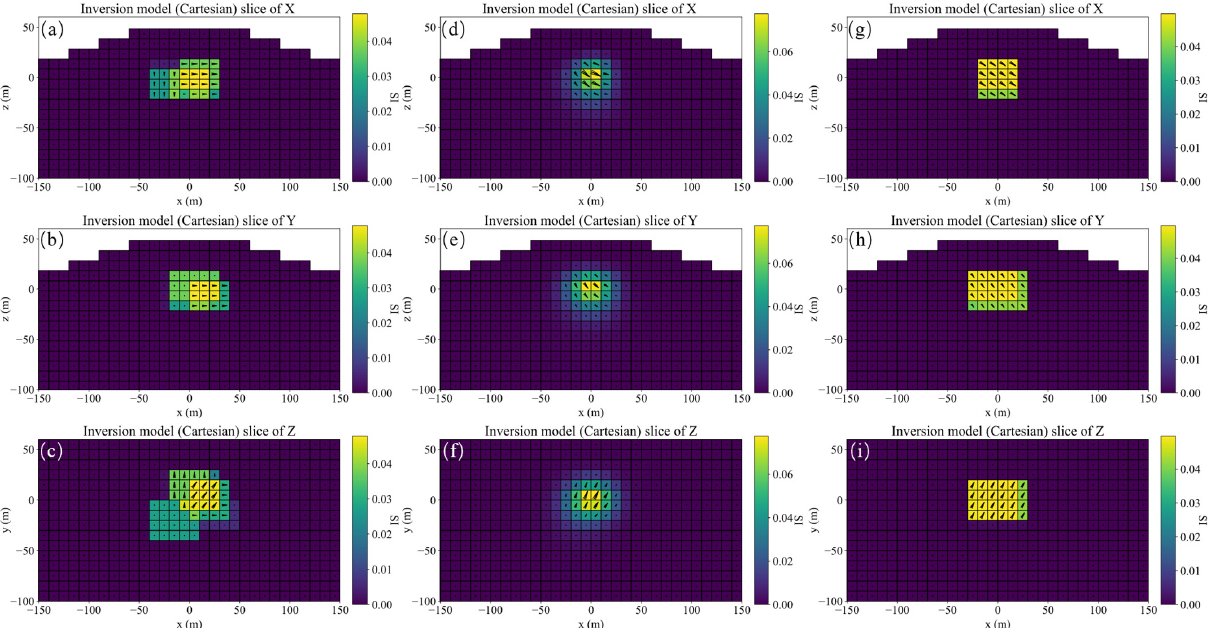
Figure 7. Slices along the X, Y, and Z directions of the magnetization vector models inverted by method 1 ( a – c ), method 2 ( d – f ), and method 3 ( g – i ), respectively.